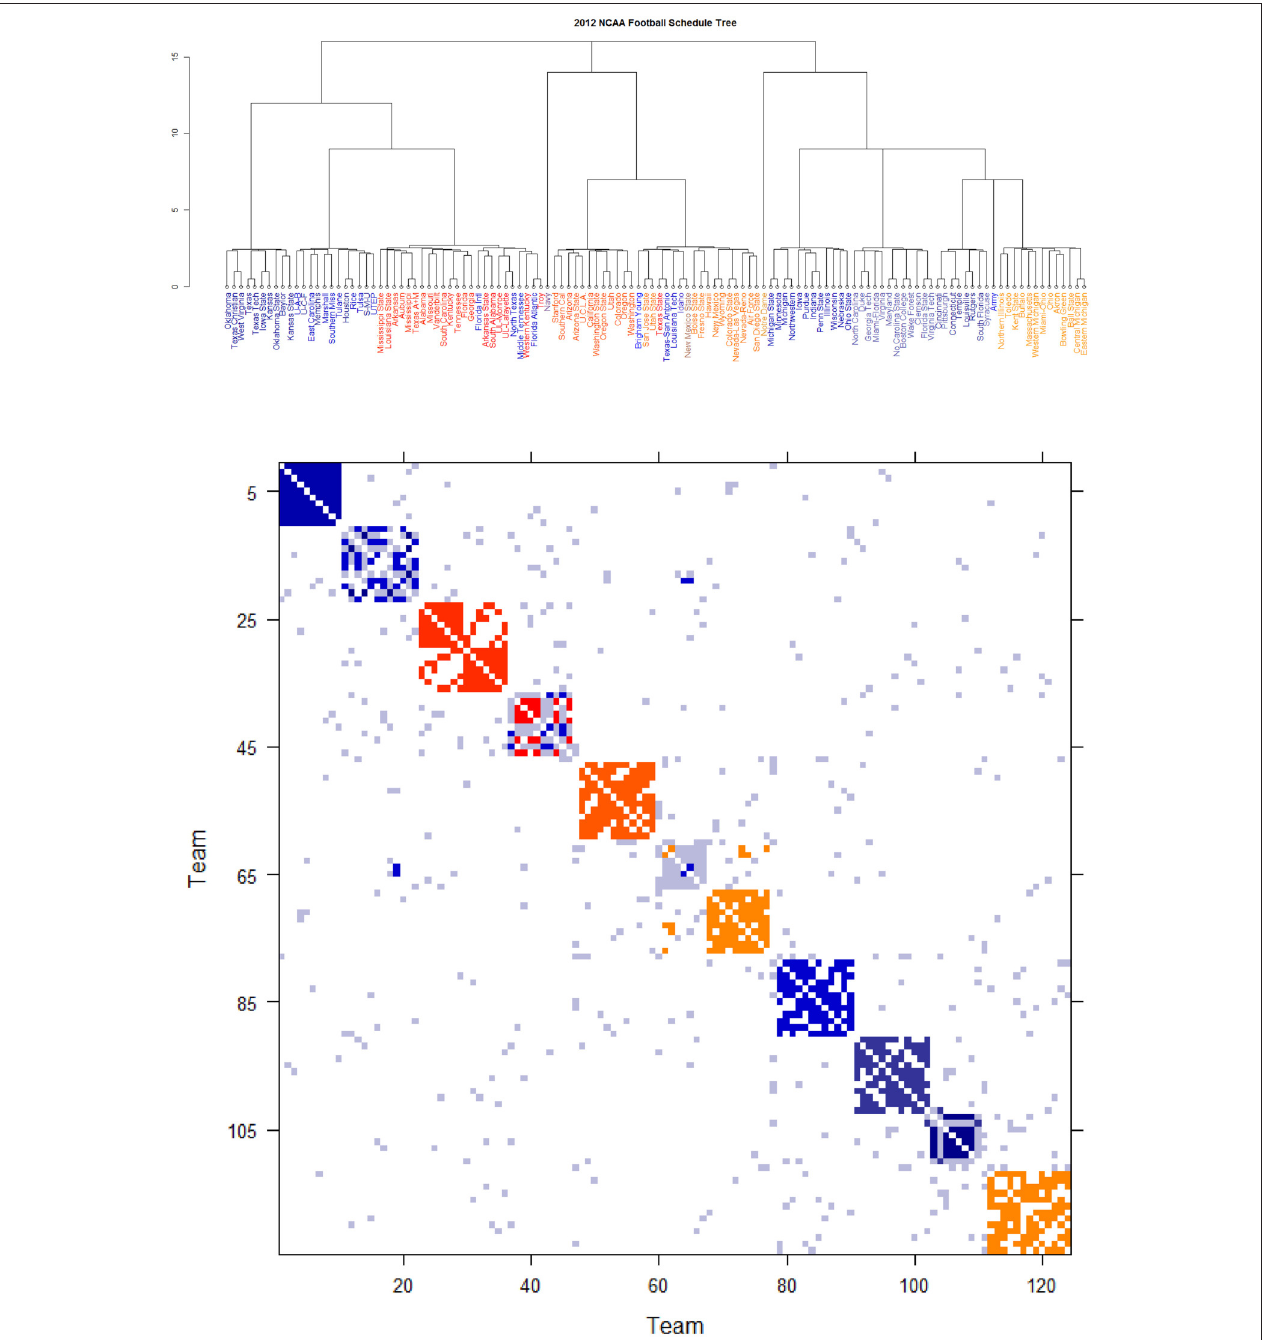
FIGURE 6 | Schedule DCG tree and its induced schedule matrix S 0 of NCAA football data on year 2012: (Upper panel) DCG tree and (Lower panel) Parisi adjacency matrix with colored diagonal blocks marking the intra-conference games for the real conferences, and off-diagonal inter-conference games are marked in gray. The six independent teams are scatted on the tree. Conferences, from blue to red, are ACC, American, Big 12, Big Ten, Conference-USA, Independent schools, Mid-American, Mountain West, Pac 12, SEC, and Sun